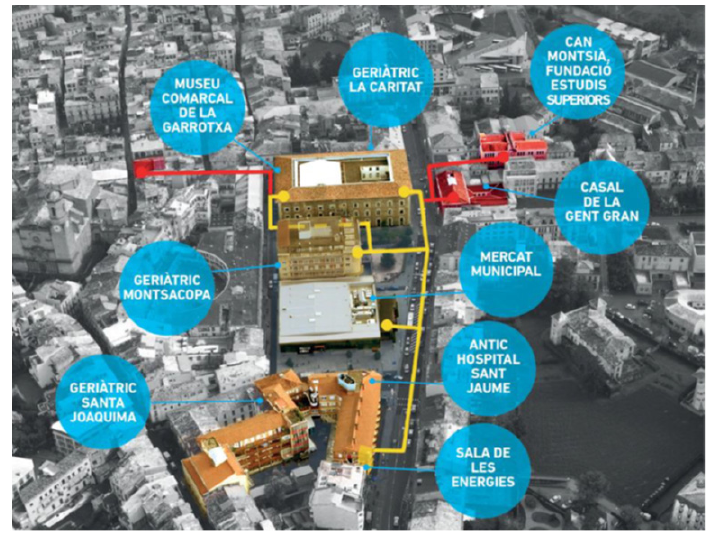
Figure 5. Olot DHC system scheme. Source: Aiguasol.